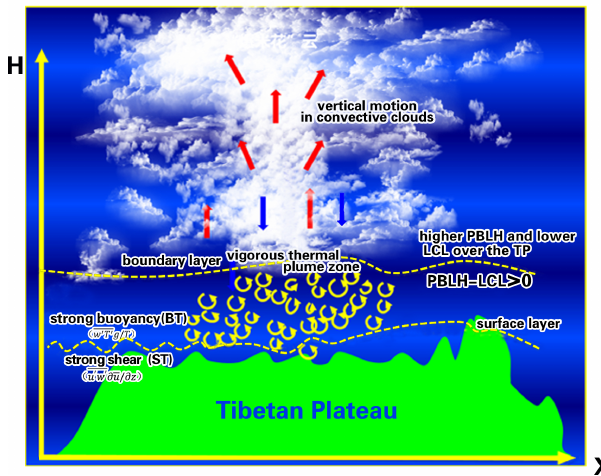
Figure 8. The characteristic model of boundary layer turbulence related to “high-efficiency” triggering mechanisms for convection over the